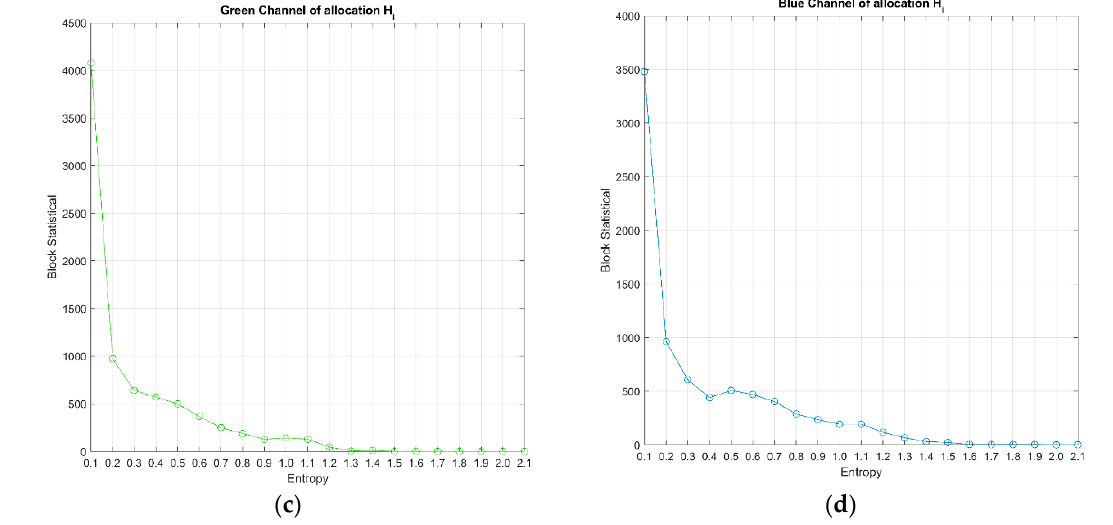
Figure 12. Entropy distributions for adaptive sampling in Pasadena-houses: ( a ) original image; ( b ) entropy in the red plane; ( c ) entropy in the green plane; and ( d ) entropy in the blue plane.